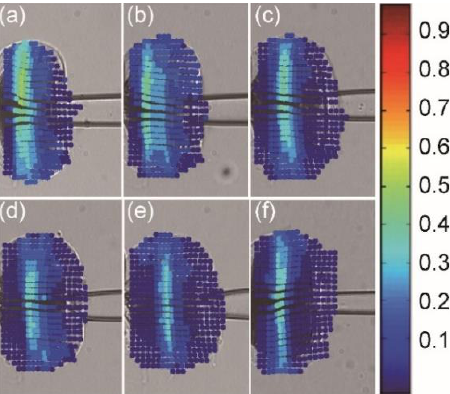
Figure 2. Intracellular strain field with the maximum deformation in the penetration process. From ( a ) to ( f ): penetration speeds of 10, 20, 30, 40, 50, and 100 µ m/s. Red and blue represent the high and low values.